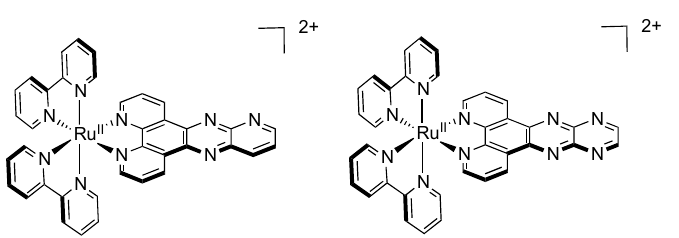
(dppp2)] 2+ (left) and [Ru(bpy) 2